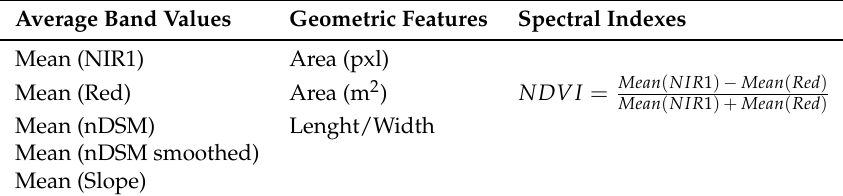
Table 1. Categories and features chosen for the building extraction